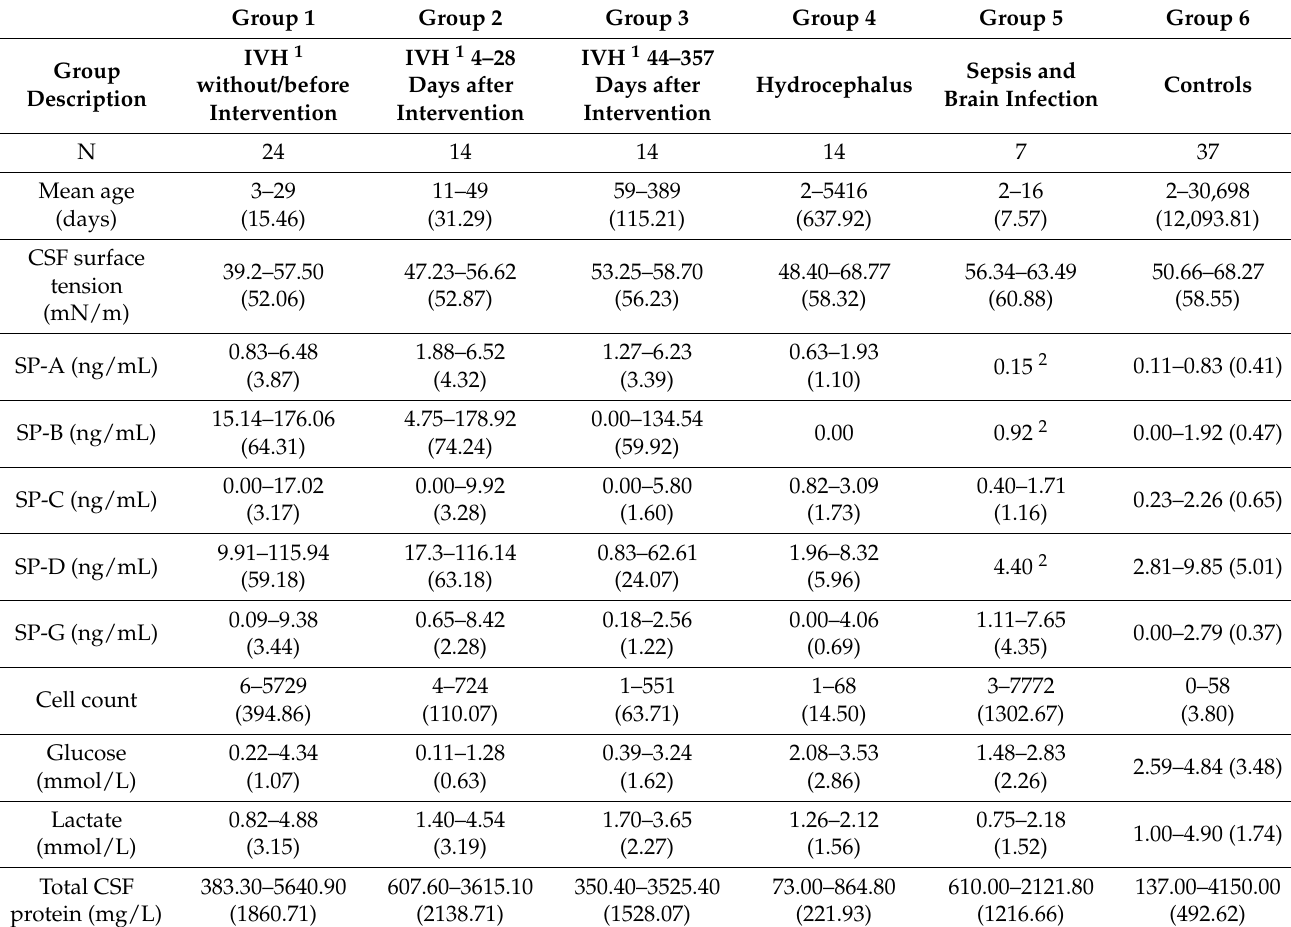
Table 1. Overview of clinical factors and laboratory parameters for the six investigated